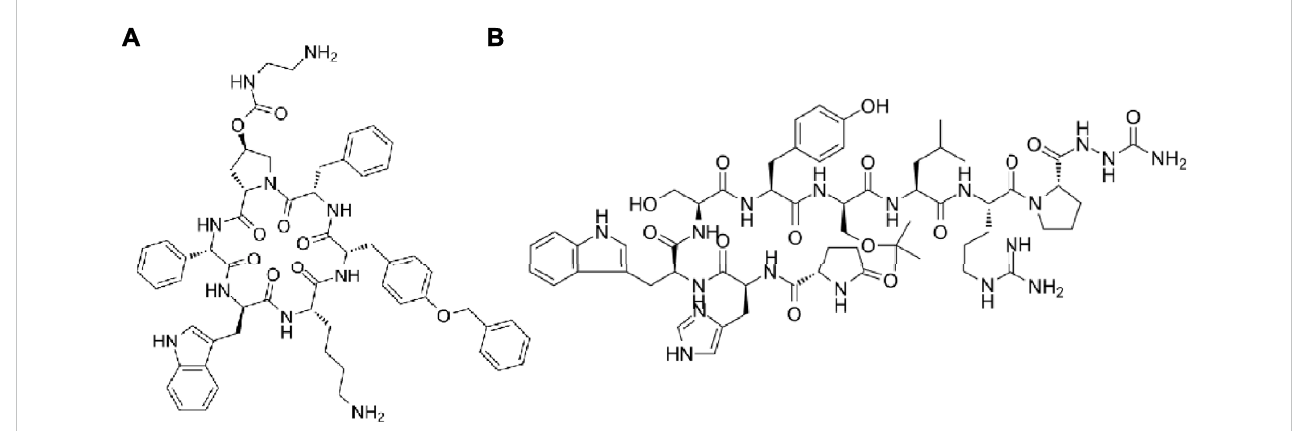
FIGURE 4 (A) The structure of pasireotide. (B) The structure of goserelin.